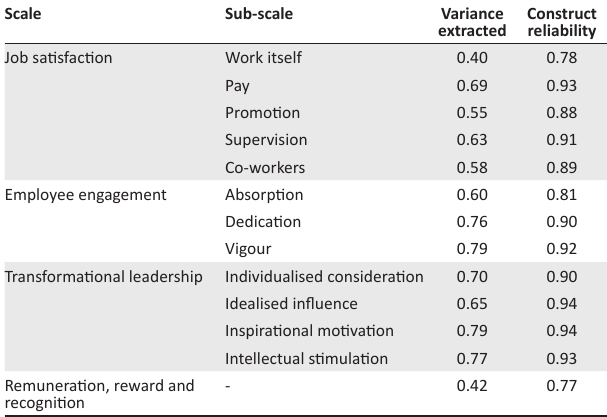
TABLE 3: Variance extracted and construct reliability of